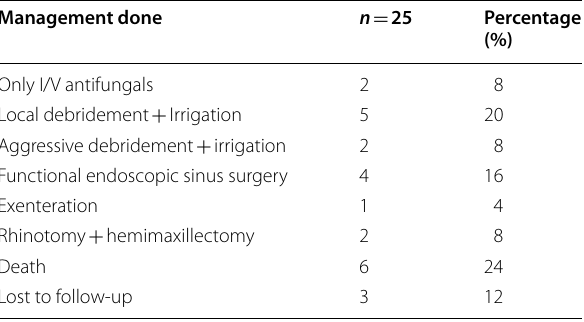
Table 6 Early clinical management or outcome for